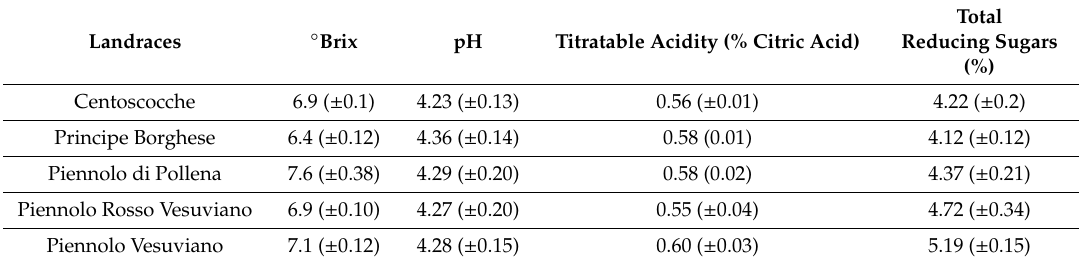
Table 1. Data of ◦ Brix, pH value, titratable acidity (as % of citric acid), and total reducing sugars (%) present in the five landraces of tomato “Piennolo”. The analysis was performed in triplicate. In brackets the standard deviation is